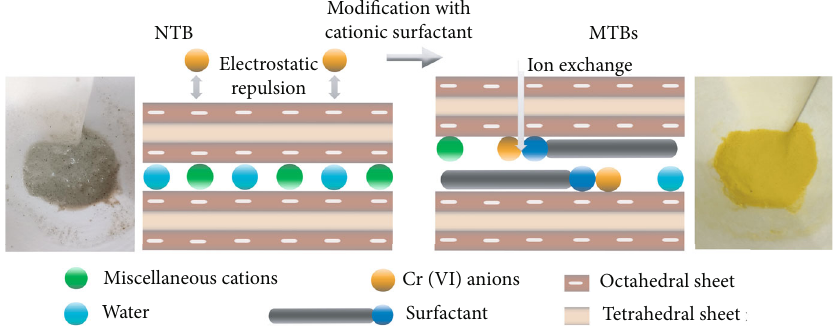
Figure 8: Adsorption mechanisms of Cr(VI) onto modi fi ed Thai